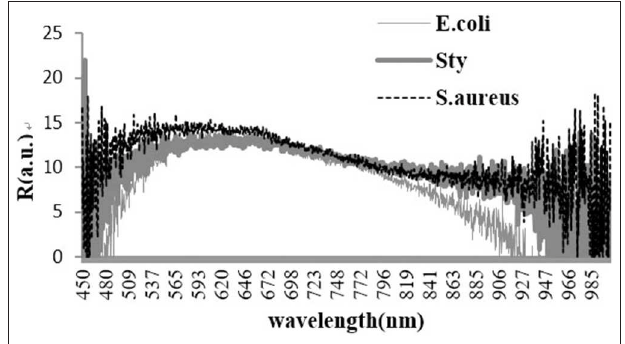
FIGURE 1 | Backscattering micro-spectra of three kinds of bacteria.